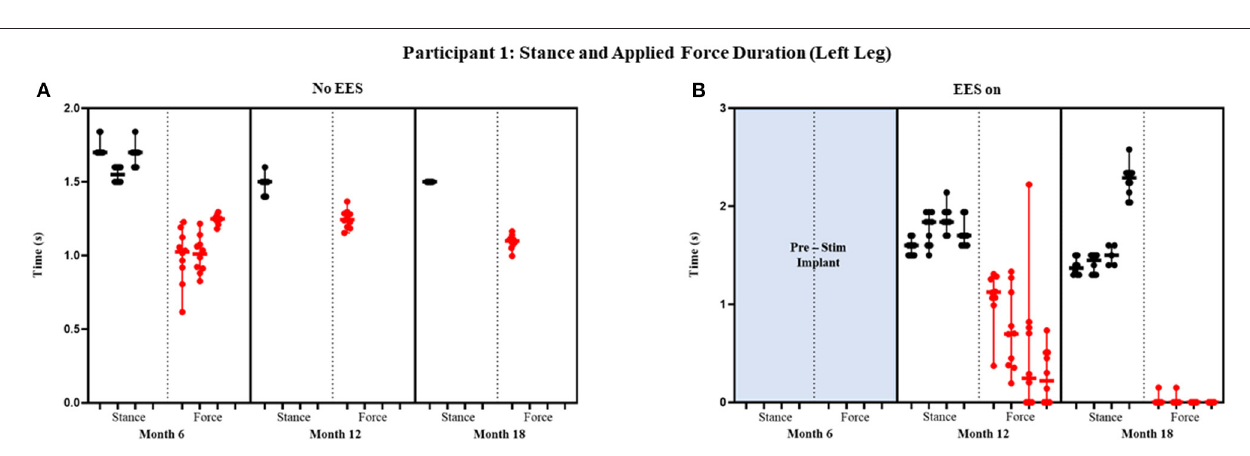
FIGURE 4 | Participant 1: stance and applied force duration left leg. Duration of stance (black dot) and applied force (red dot) with line at the median and range for left leg during no EES (A) and EES on (B) . Each tick in the x-axis represents a dataset of up to 10 consecutive cycles.